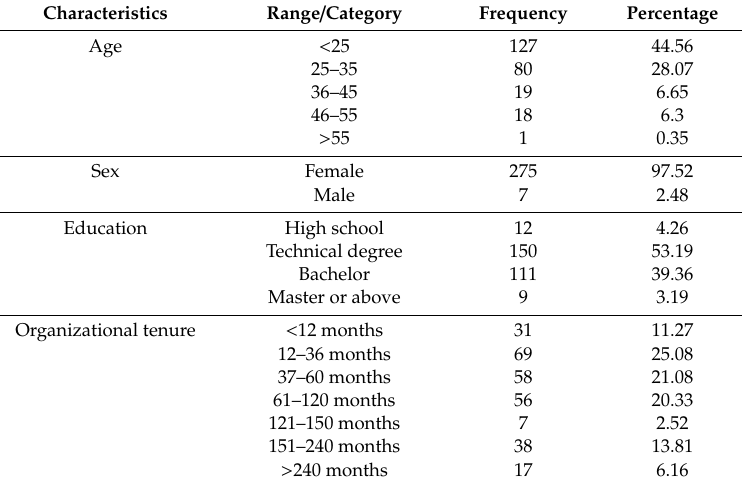
Table 1. Sociodemographic characteristics of the nurse sample.